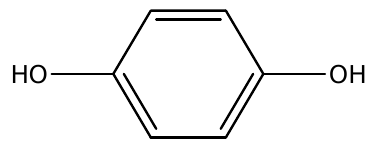
Figure 1. Chemical structure of